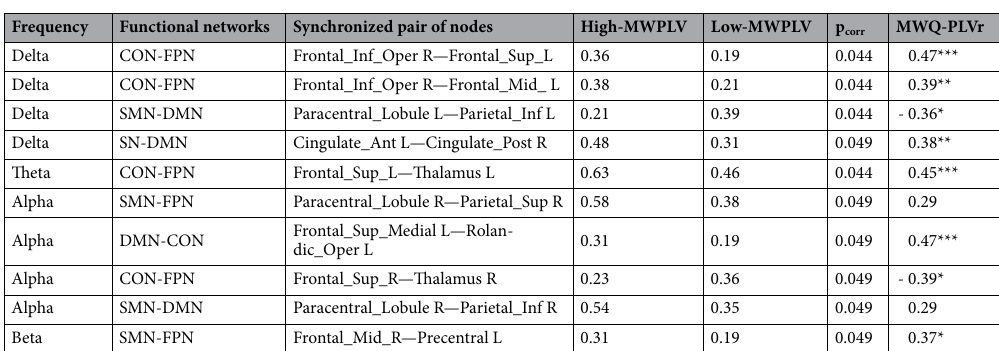
Table 3. Inter-networks significant differences between subpopulations differing with regard to dispositional Mind Wandering and the results of Pearson’s linear correlations (r) between MWQ total score and PLV in the whole sample. p corr —permutation test’ level of statistical significance, including FDR correction. *Correlation significant at p < 0.05. **Correlation significant at p < 0.01. ***Correlation significant at p <